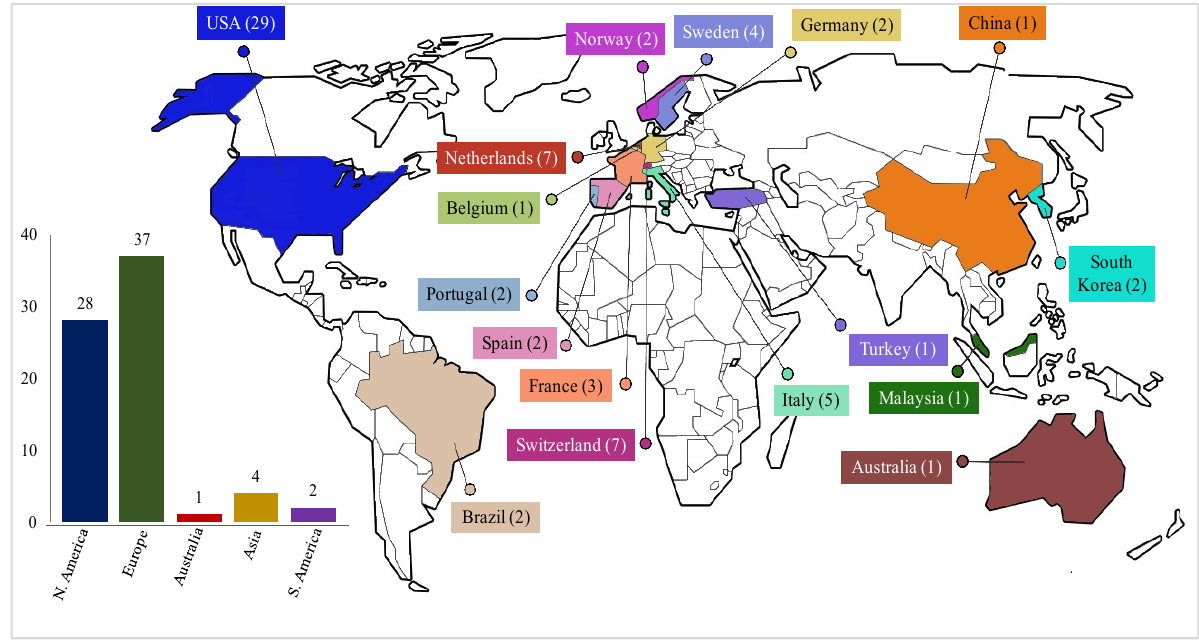
Figure 4. Total of published papers for each continent and country.